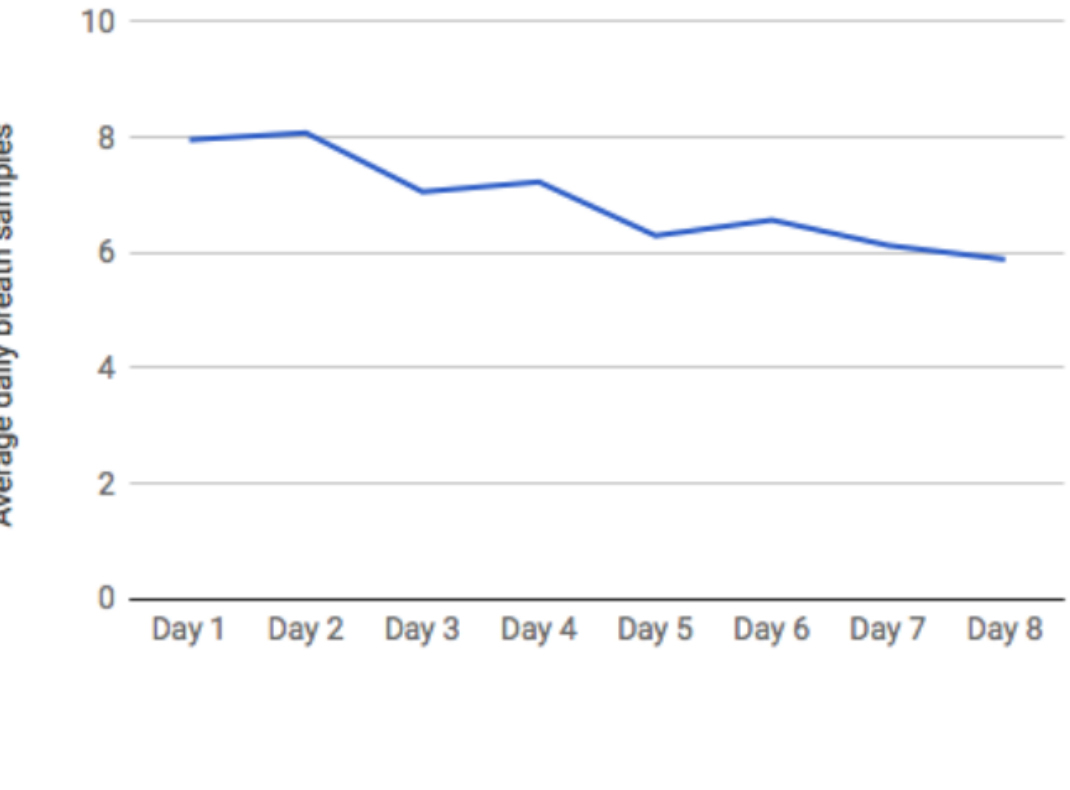
Figure 4. Average daily breath sensor